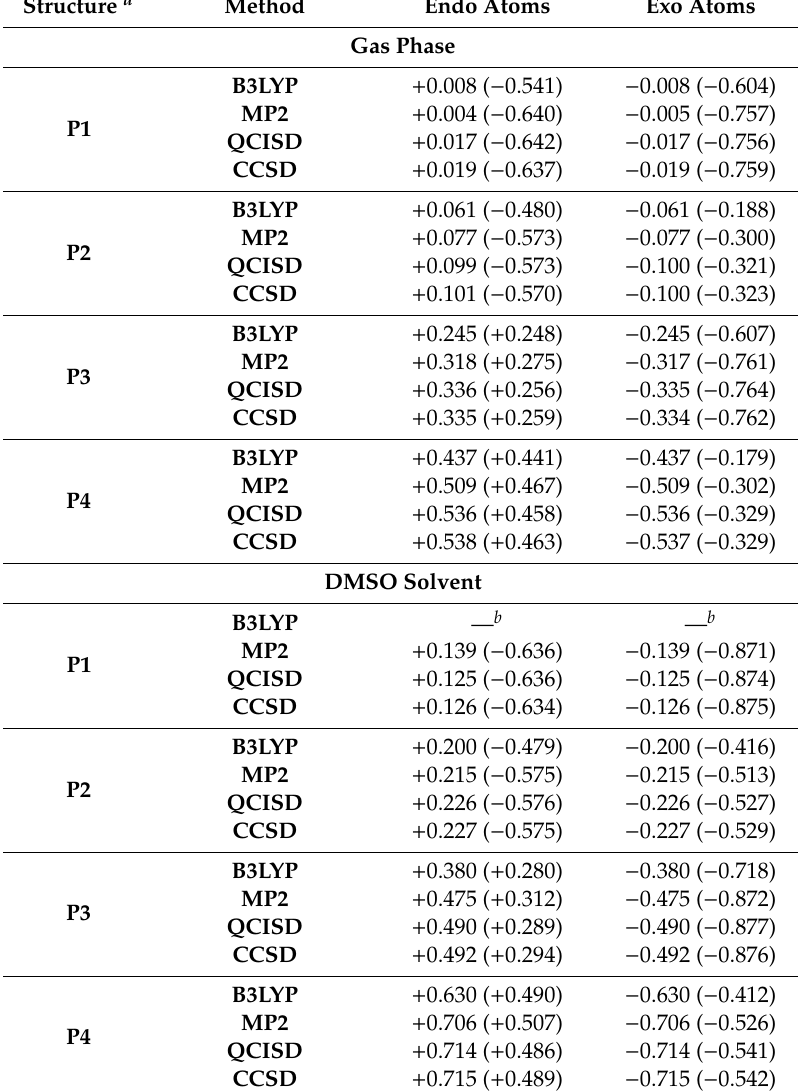
Table 5. NBO charges on exo and endocyclic atom groups on the aug-cc-pVDZ basis set. Values in parentheses correspond to the partial charges of exo Y and endo X